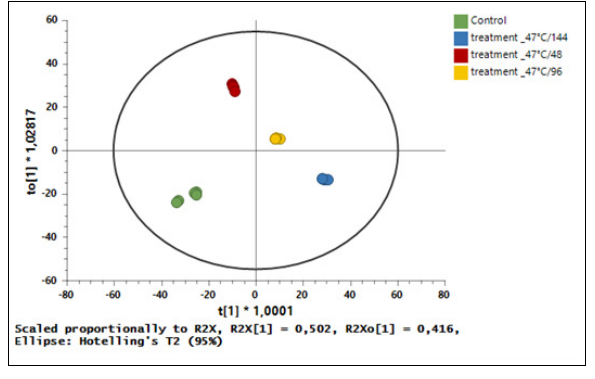
Orthogonal projections to latent structures discriminant analysis (OPLS-DA) scores scatter plot of Lippia javanica exposed to 25 °C (control) and 47 °C (for 48, 96 and 144